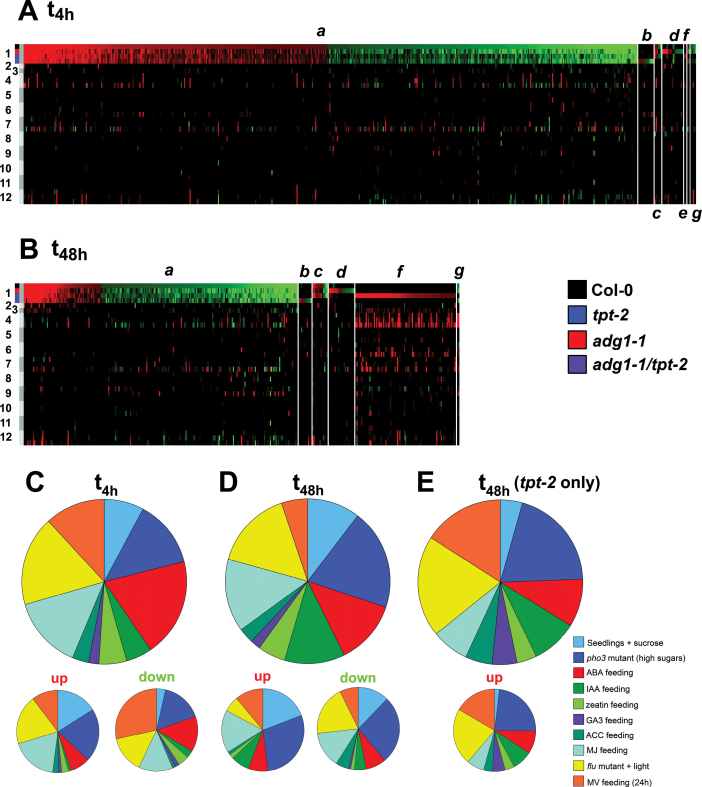
Heat map presentation of up- [red (log2max=3)] and down-regulated [green (log2min= –3)] genes of in-house microarrays at t
4h versus t
0 (A) or t
48h versus t
0 (B) compared with publicly available microarrays based on Supplementary Table S8 available at JXB online. The numbers to the left indicate in-house arrays (1) with Col-0, tpt-2, adg1-1, and adg1-1/tpt-2 labelled with the colours black, blue, red, and dark purple, respectively; (2) seedlings+sucrose; (3) pho3 mutant; (4) flu mutant; (5) flu mutant+MV; and feeding of the wild type with (6) MV, (7) ABA, (8) tZ, (9) IAA, (10) ACC, (11) GA3, or (12) MJ. The small italic letters indicate (a) commonly de-regulated genes in wild-type and all mutant plants of the in-house arrays, (b) specifically altered genes in adg1-1/tpt-2, (c) specifically not regulated genes in adg1-1/tpt-2, (d) specifically altered genes in adg1-1, (e) specifically not regulated genes in adg1-1, (f) specifically altered genes in tpt-2, and (g) specifically not regulated genes in tpt-2. Relative distribution of overlaps between differentially regulated genes in public microarrays compared with altered genes in all biotypes investigated in this study at t=4h (C) and t=48h (D) after LL/HL transfer. In (E), the relative distribution of overlaps between differentially regulated genes in publicly available microarrays is compared with up-regulated genes only found in the tpt-2 mutant. The smaller pie charts refer to the relative distribution of up- or down-regulated genes between the individual experiments.